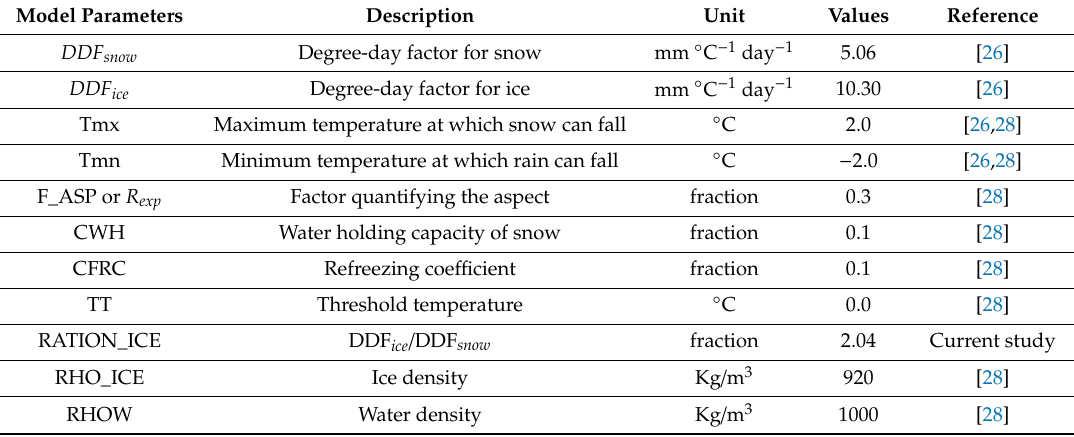
Table 3. Parameters used in DDM for the Nam Co